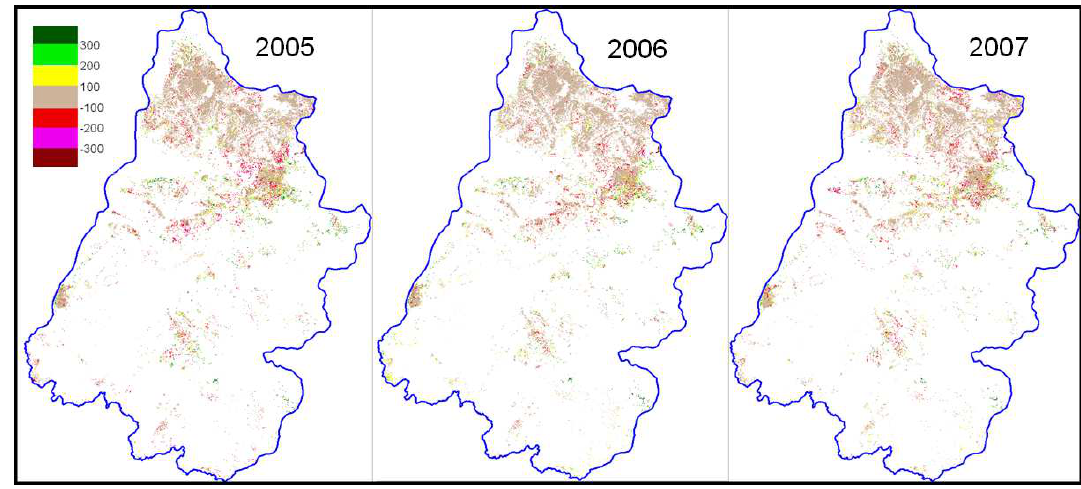
Figure 5. Ecosystem performance anomaly maps for big sagebrush areas in the UCRB. Yellow-green areas represent overperformance and are greater than the 90% confidence limit above the regression line. Red-pink areas represent underperformance and are greater than the 90% confidence limit below the regression line.